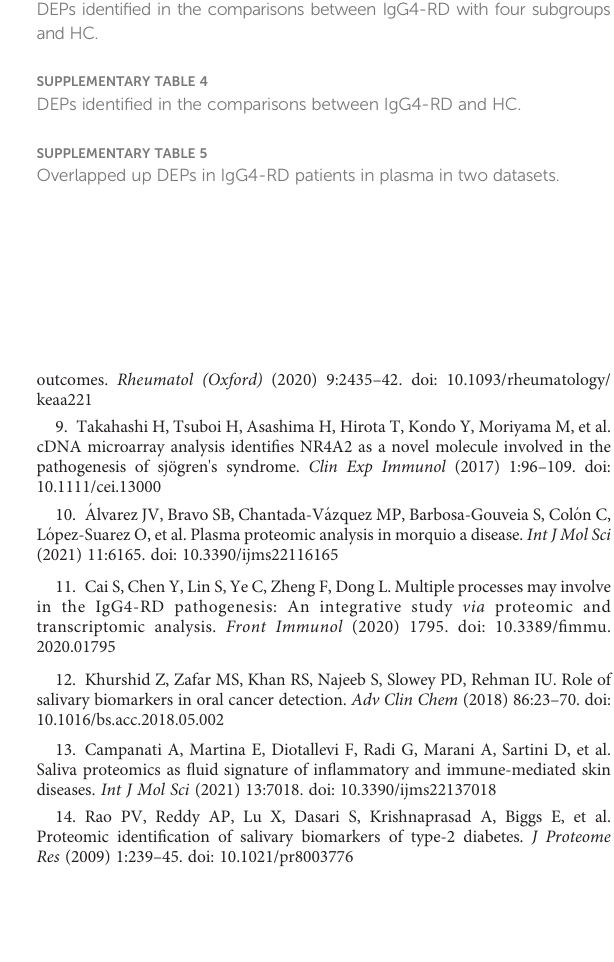
SUPPLEMENTARY TABLE 3 DEPs identi fi ed in the comparisons between IgG4-RD with four subgroups and HC. SUPPLEMENTARY TABLE 4 DEPs identi fi ed in the comparisons between IgG4-RD and